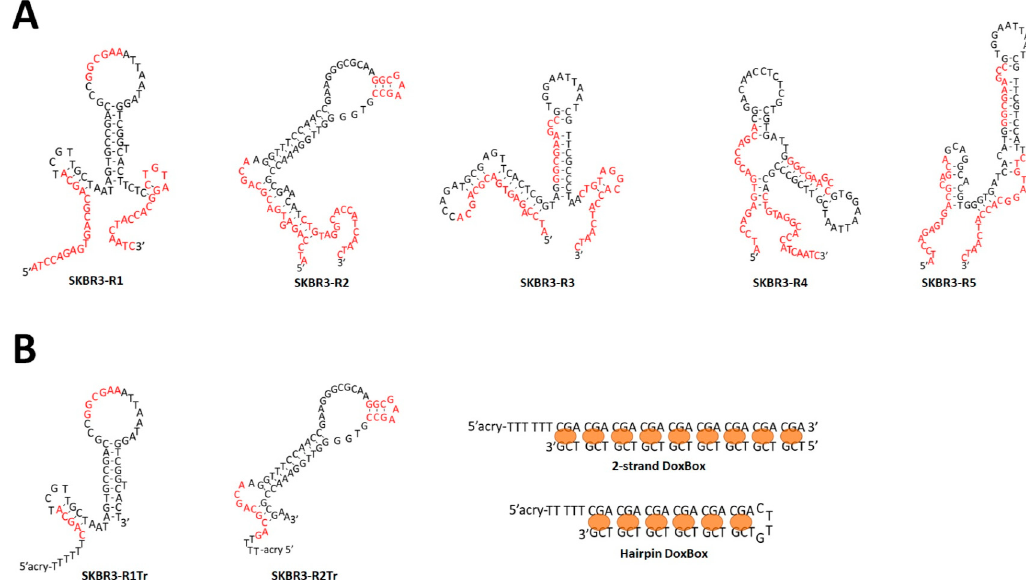
Figure 2. ( A ) Predicted secondary structures of the top 5 raised aptamers. Structures were obtained with the DNA folding